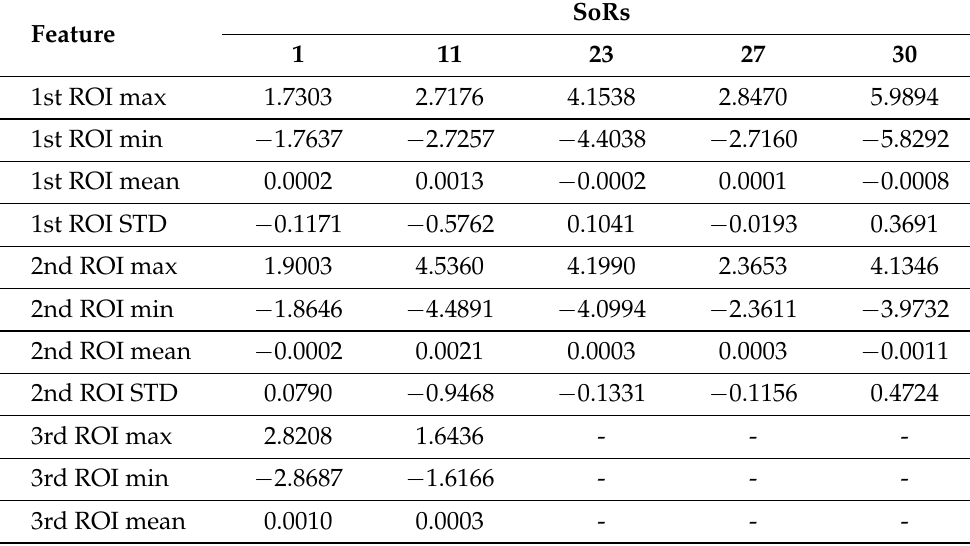
Table 14. Mean values for features on SoRs from autistic